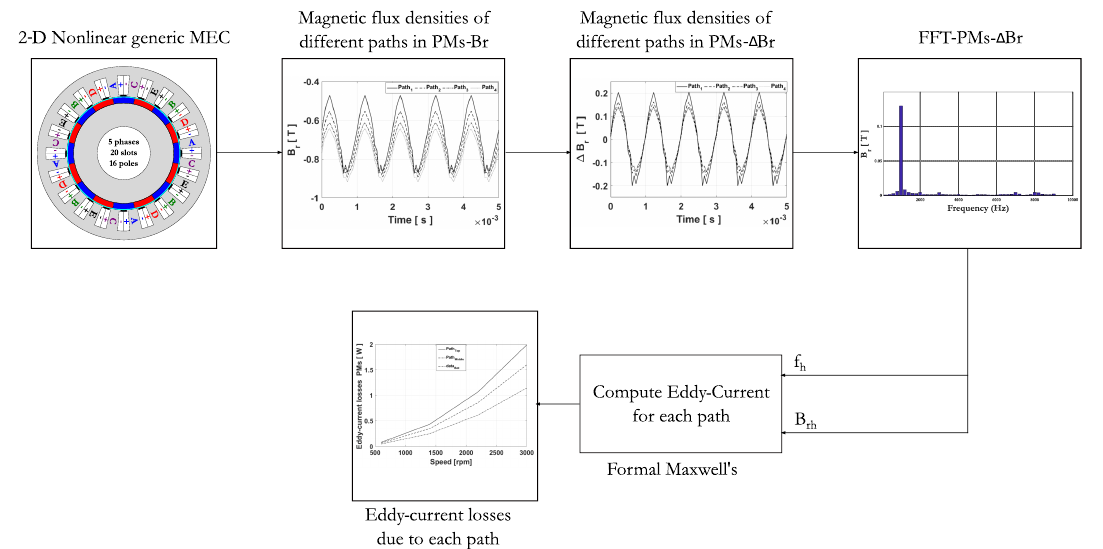
Figure 1. General flowchart of hybrid multi-layer model.